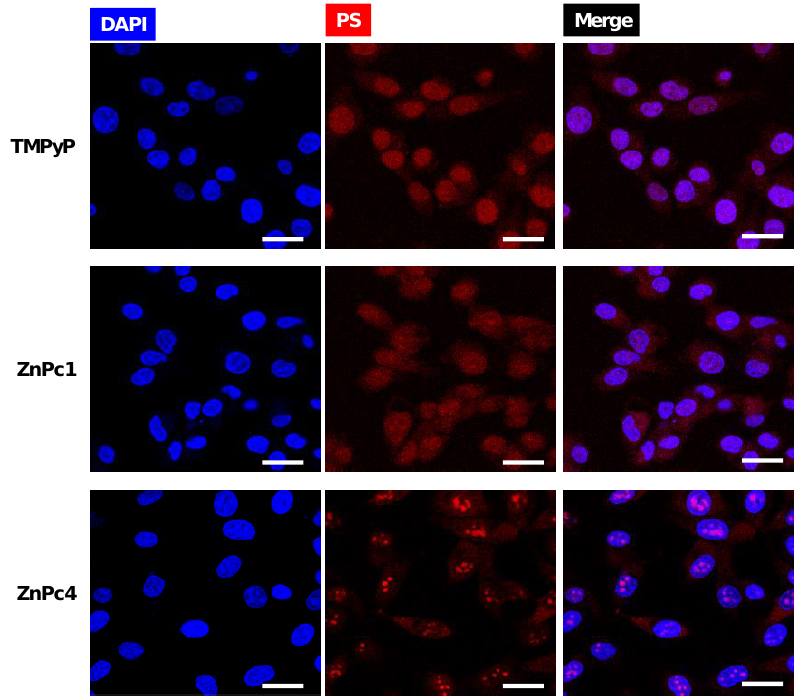
Figure 12. Representative fluorescence images of UM-UC-3 bladder cancer cells incubated with the ligands (red) TMPyP (30 μM), ZnPc1 (20 μM) or ZnPc4 (45 μM) for 48 h of incubation. DAPI is staining the nucleus. Scale bars 20 μM.